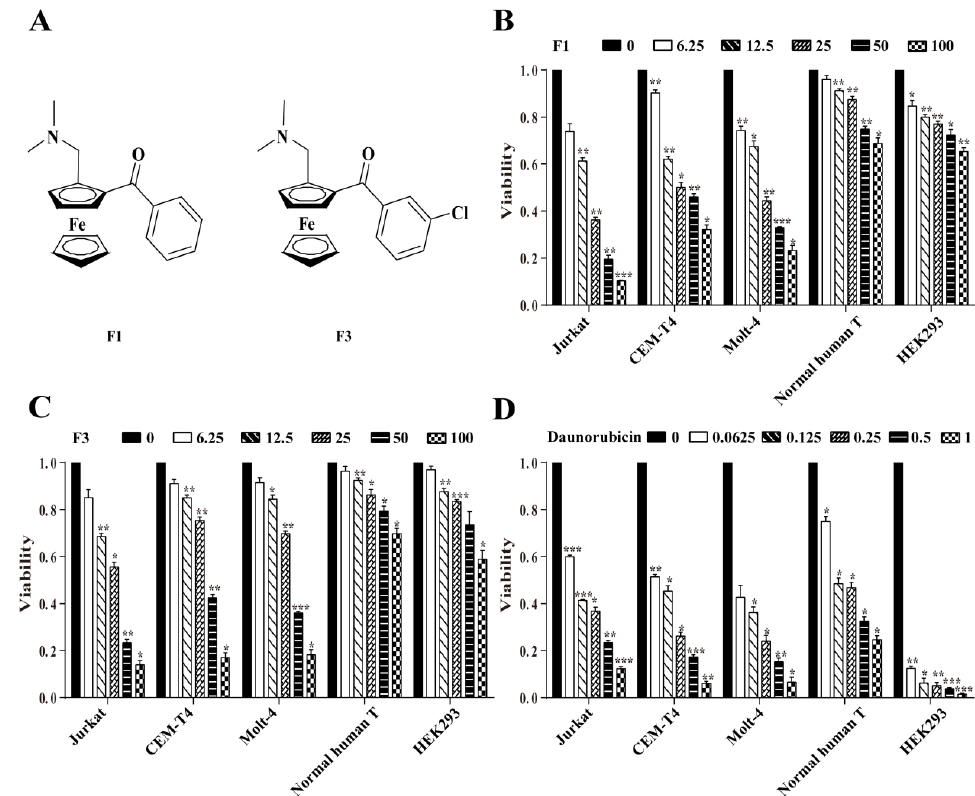
Figure 1. Viability of Jurkat, CEM-T4, Molt-4, Normal human T, and HEK293 cells treated by F1, F3, and Daunorubicin, respectively. ( A ) Chemical structures of F1 and F3. ( B – D ) Viability of Jurkat, CEM-T4, Molt-4, Normal human T, and HEK293 after in the presence of F1, or F3 at different concentrations (0, 6.25, 12.5, 25, 50 and 100 µM) for 48 h. Daunorubicin at different concentrations (0.0625, 0.125, 0.25, 0.5 and 1 µM) for 48 h. The data were expressed as the mean ± SEM of three independent experiments. * p < 0.05, ** p < 0.01 and *** p < 0.001 vs. the control group.